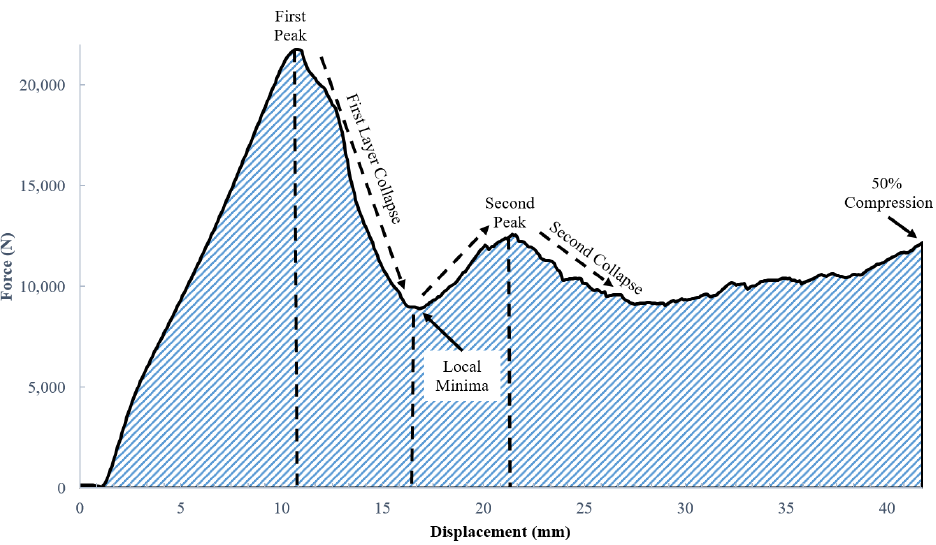
Figure 16. Results of quasi-static compression testing on a 7 × 7 × 7 unit cell octet truss specimen. The hatched area under the Force versus Displacement curve in Figure 16 represents energy absorbed by the structure during quasi-static compression. This area was measured to be 463.2 N mm (= 0.4632 J) using a piecewise integration of the raw Force versus Displacement data in Excel up to 50% compression. Specific energy absorption (SEA) is equal to energy absorbed divided by the mass of the lattice structure. The sample used